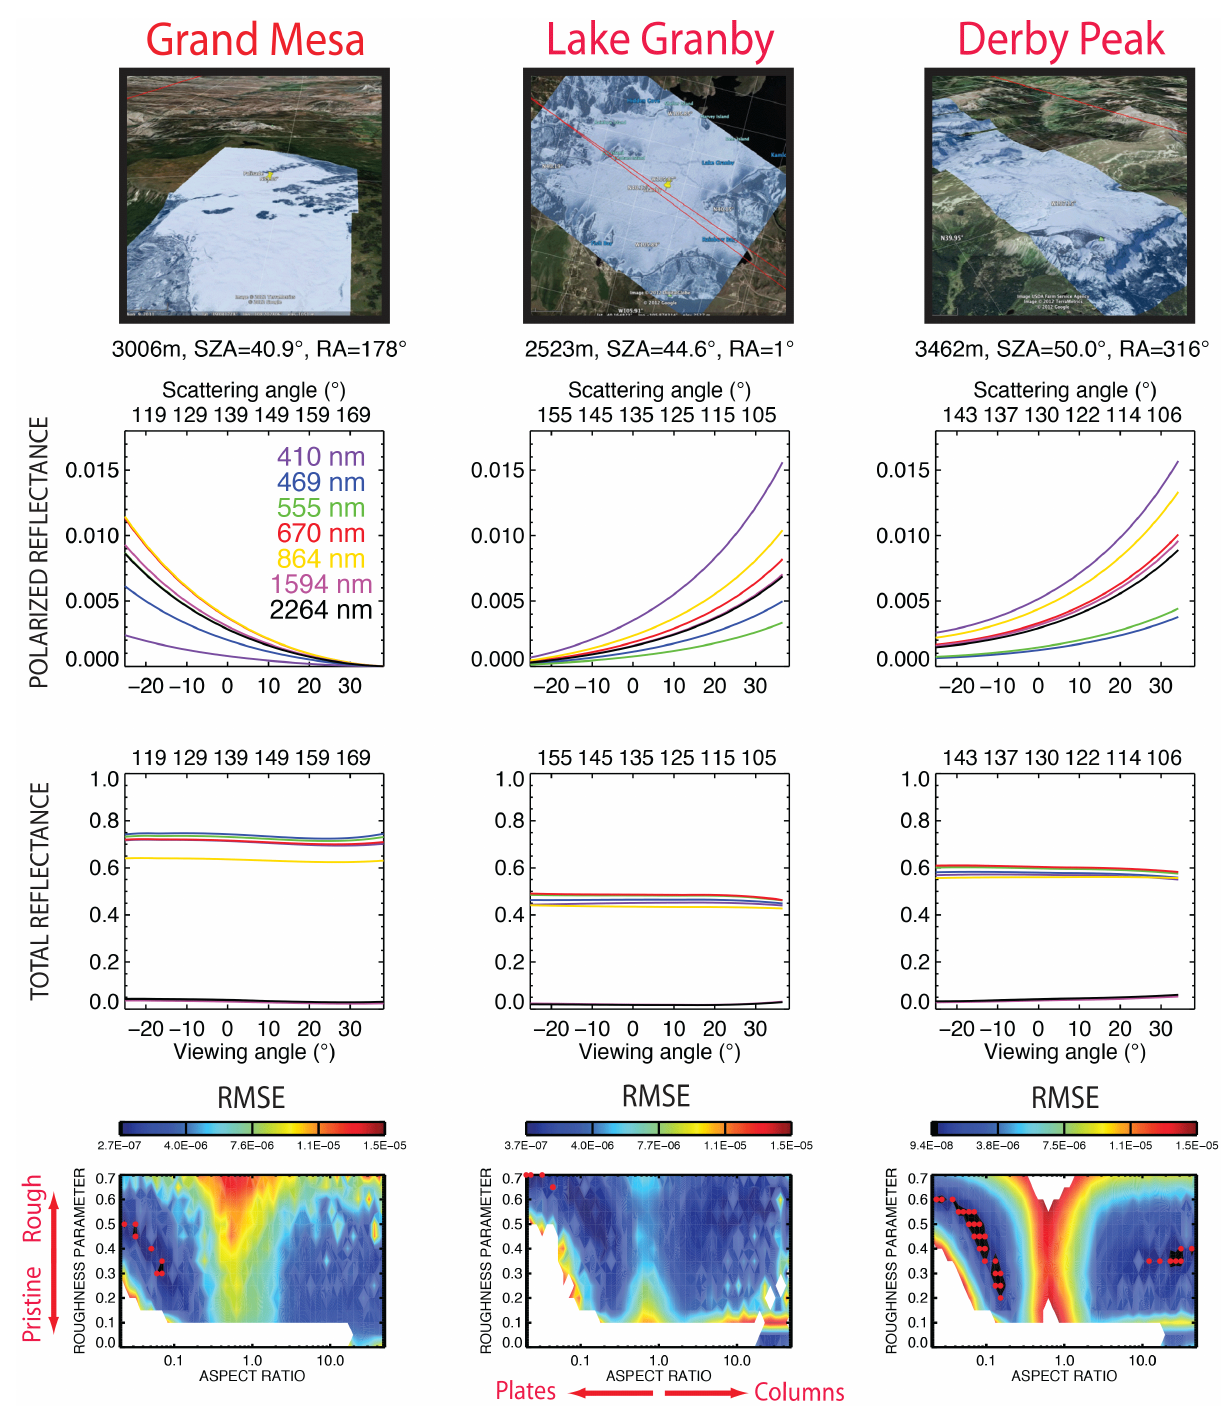
Figure 1. Atmospherically corrected polarized (second row) and total (third row) reflectance for three snowfields (columns) overflown in Colorado, USA. The first row shows real-time imagery from the high-resolution camera onboard the ER-2, captioned by the scene altitude above sea level together with the solar zenith angle and the Sun-sensor relative azimuth at the time of observation. The last row pertains to the search of the optimal ice grain model: the contour plots map the RMSE of the fit to the polarized reflectance at 864nm when simulating the snowpack with each crystal habit (i.e., each combination of aspect ratio and roughness parameter) in the database. The red circles locate the values of the RMSE falling under a predetermined threshold and are taken to represent the retrieved (optimal) habits.